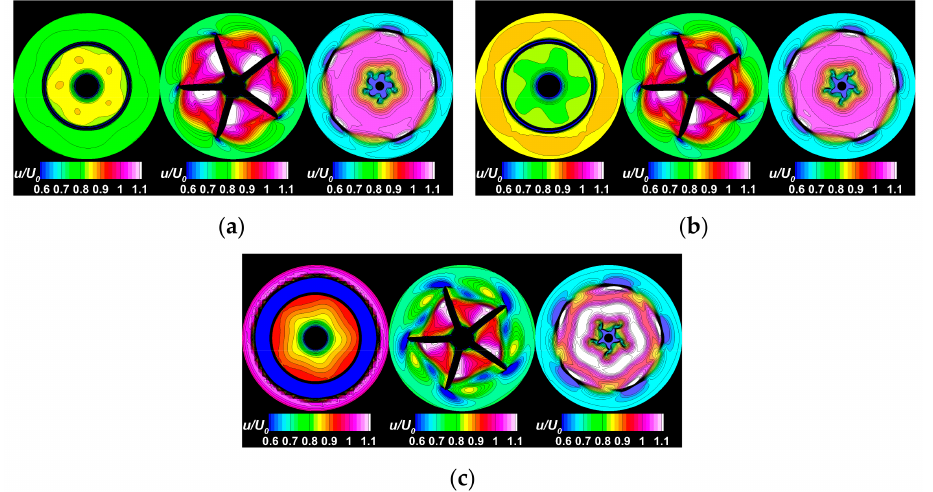
Figure 12. Comparison of the instantaneous non-dimensional axial velocity fields computed at 0.5 R upstream of the propeller (left), in the propeller plane (middle) and at 0.5 R downstream of the propeller (right) for D N / D = 0.7, J = 0.7 : ( a ) θ = 0 ◦ , ( b ) θ = 10 ◦ , ( c ) θ = 20 ◦ .